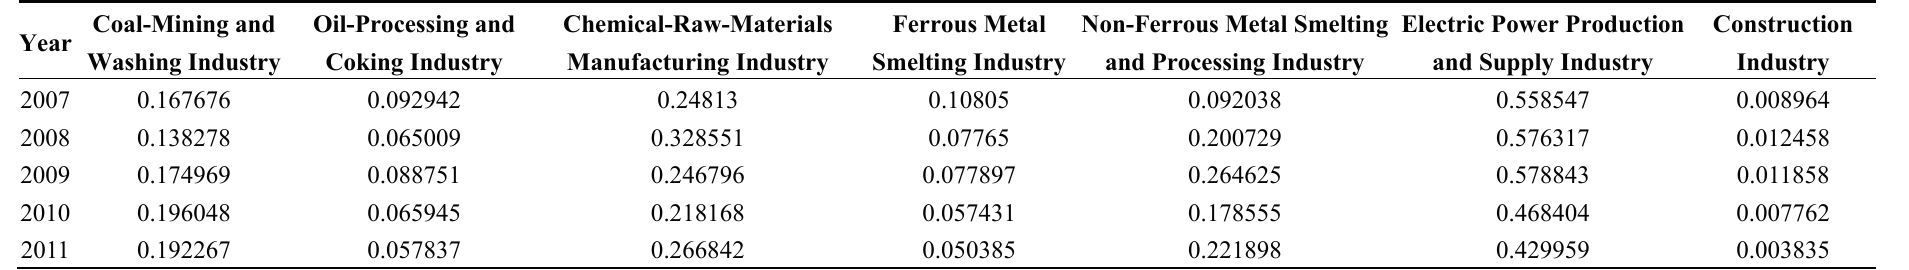
Table 13. The capital investments needed per 10 thousand yuan of industries in Shanxi Province from 2007 to 2011 (10 thousand